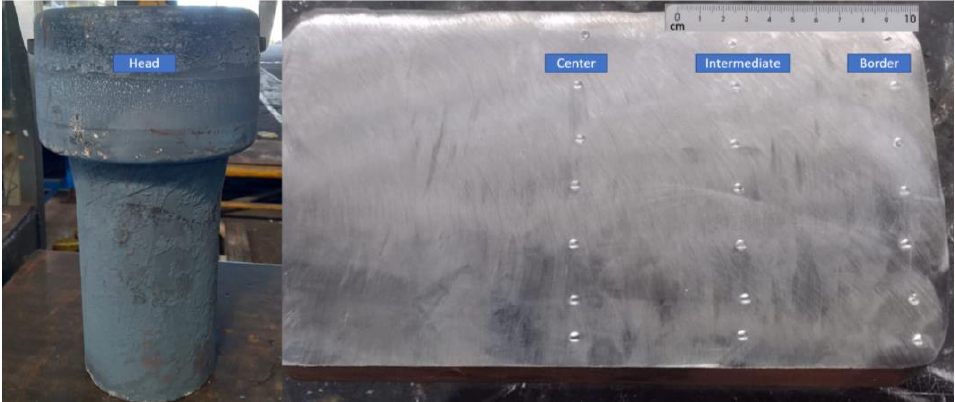
Figure 9. The markings from the Brinell hardness test.